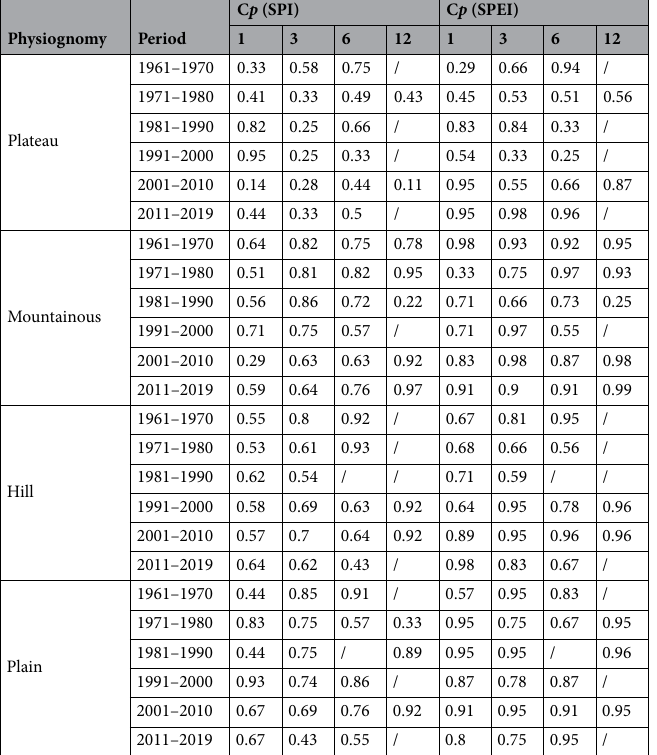
Table 3. Conditional probability of SPI and SPEI (C p (SPI) and C p (SPEI)) in different geomorphic types in Sichuan province in different periods and time scales. (‘/’ means that there is no drought, so the conditional probability cannot be